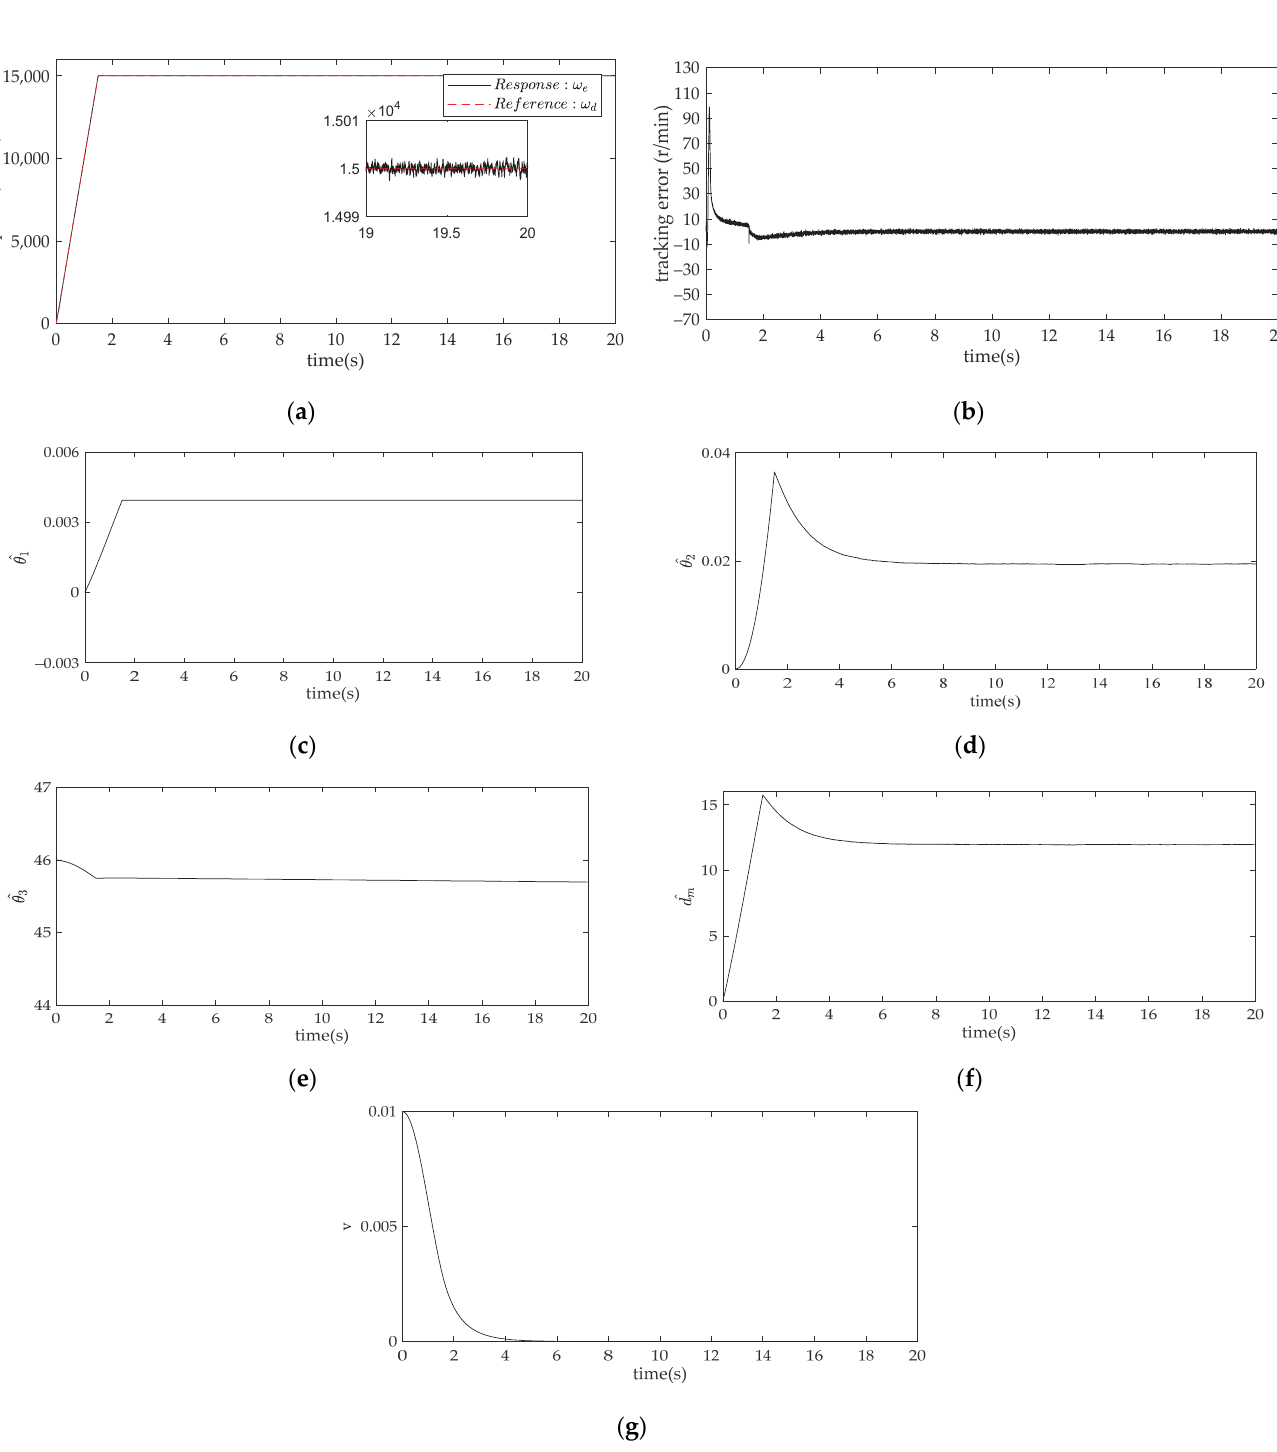
Figure 8. ( a ) Speed response under adaptive robust control; ( b ) Tracking error of adaptive robust control; ( c – g ) Parameter adaptation of the proposed adaptive robust control.